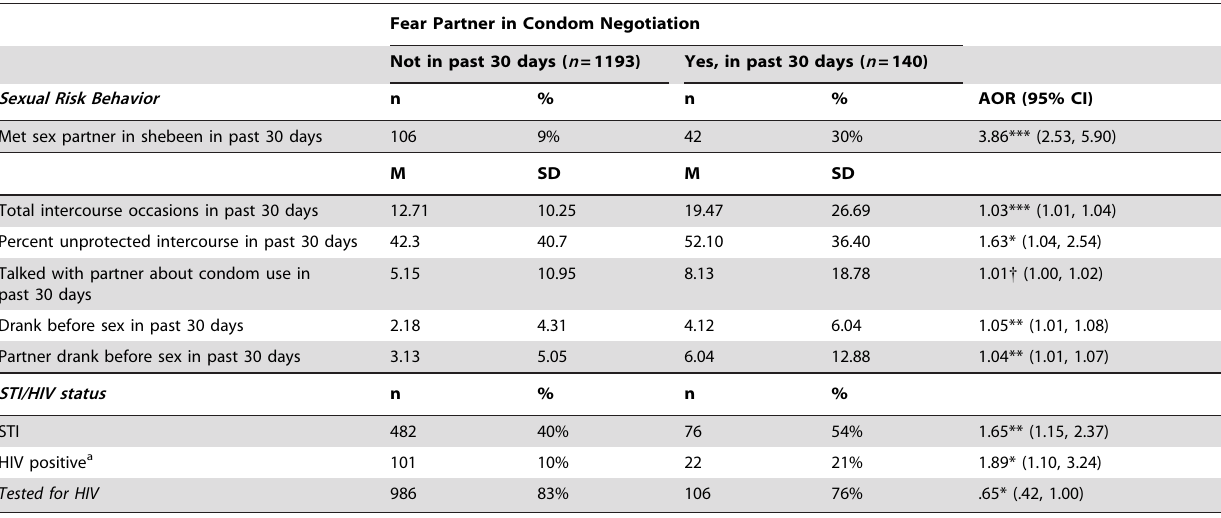
Table 3. Sexual risk behavior, STI and HIV status, and HIV testing by fear of partner in condom negotiation ( n =1333).